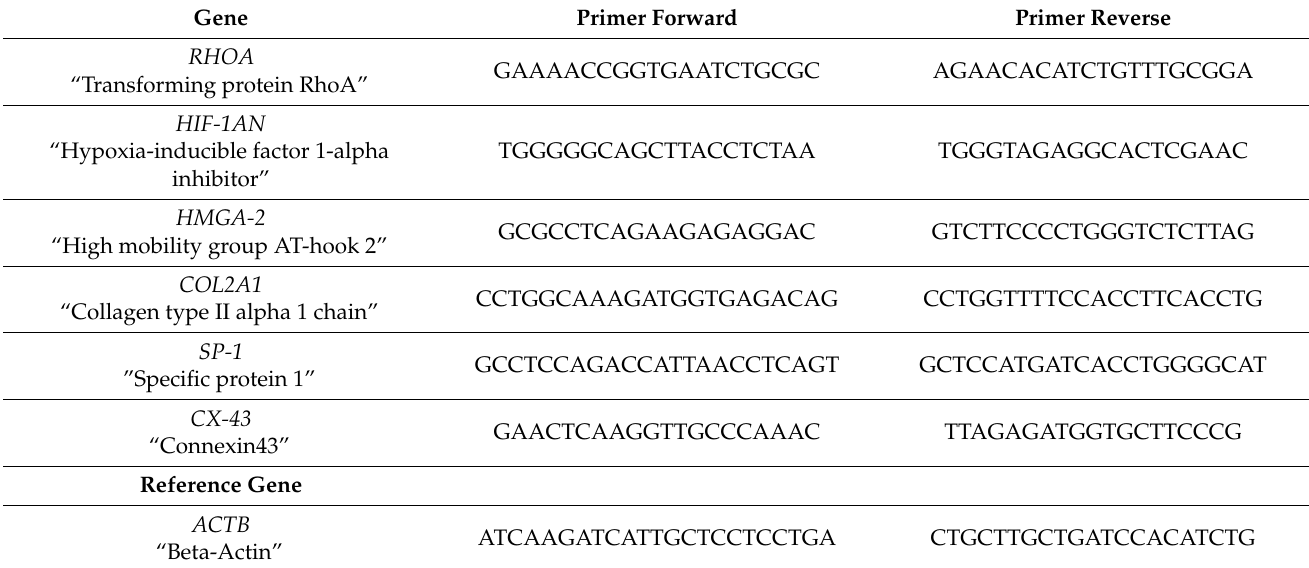
Table 2. List of gene primers used to study gene expression profiling. Their expression was normalized to the β -actin housekeeping